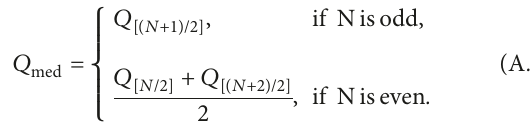
Figure S1: the incidence (PI) and contribute (PC) of different precipitation grades to the total frequency and amount for the 30 stations during 1960–2012. Figure S2: the urban built- up areas in Beijing during 1950–2012. ( Supplementary Materials